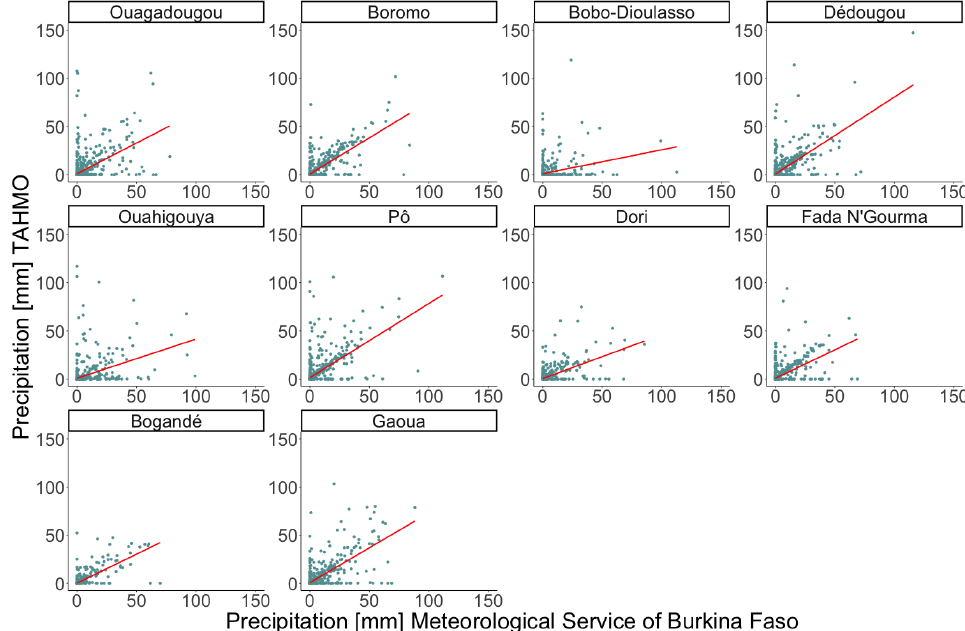
Figure 12. Scatterplot between precipitation time series of TAHMO stations ( y -axis) and the corre- sponding stations from meteorological service of Burkina Faso ( x